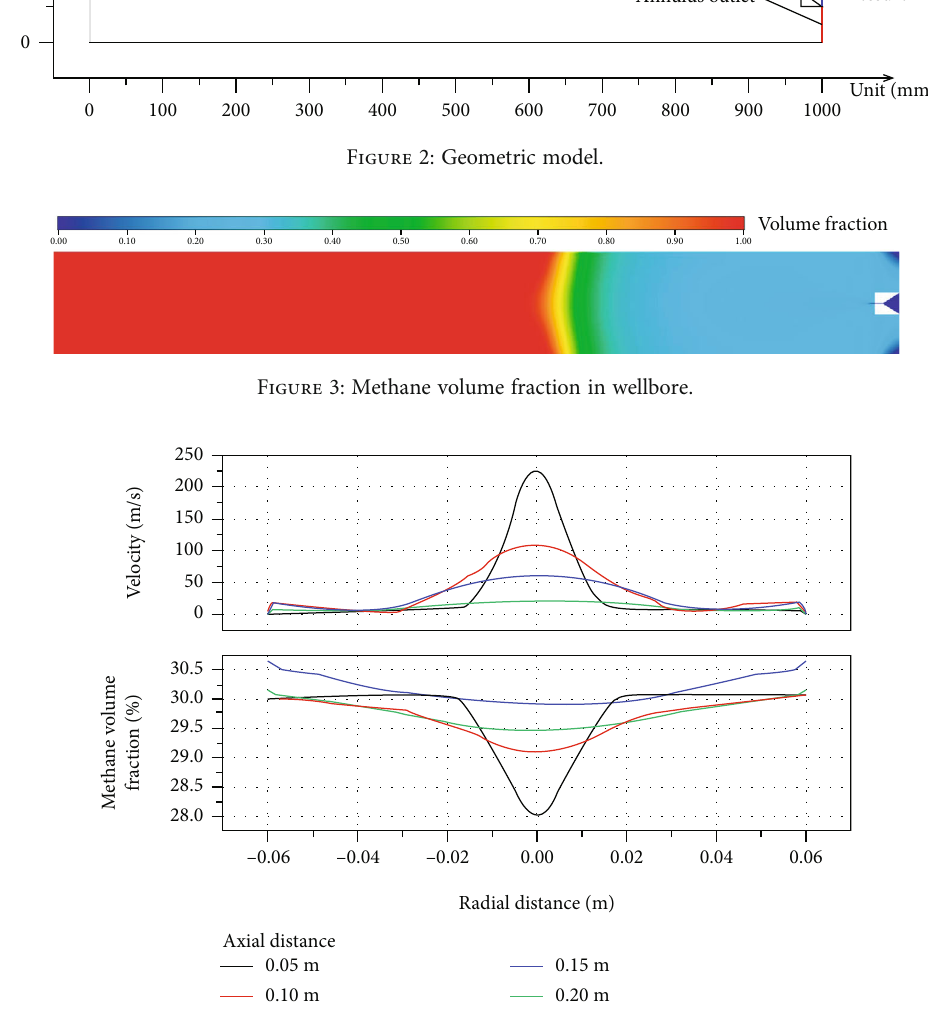
Figure 2: Geometric model.